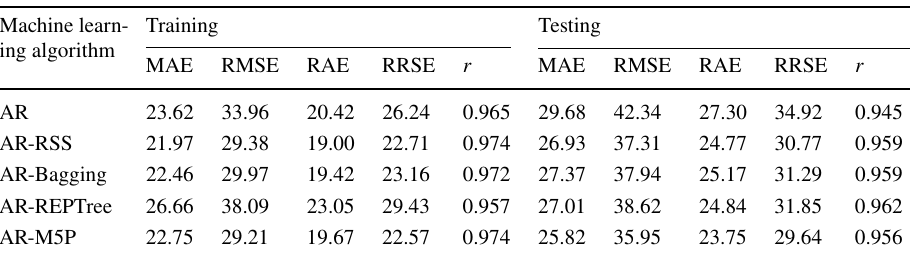
Machine learn- ing algorithm